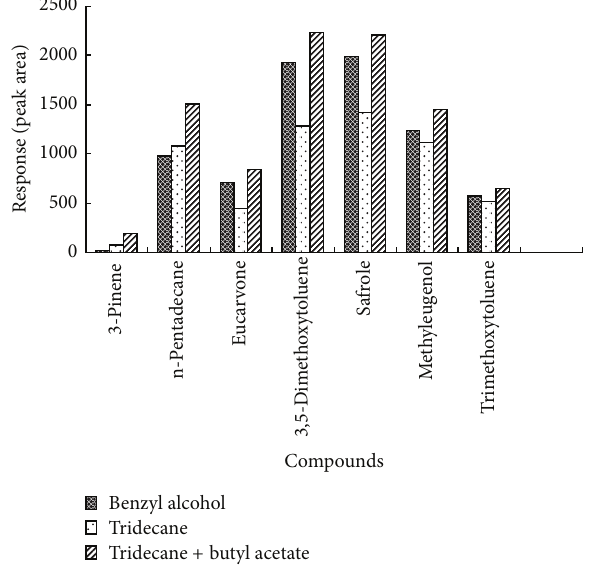
Figure 1: Comparison among different extraction solvents on the relative peak area of the seven main compounds from Herba Asari. Powdered sample, 0.500 g; extraction solvent volume, 0.6 𝜇 L; parti- cle size, 100mesh; extraction time, 20min, extraction temperature, 70 ∘ C; the percent between two mixed solvent, 1:1